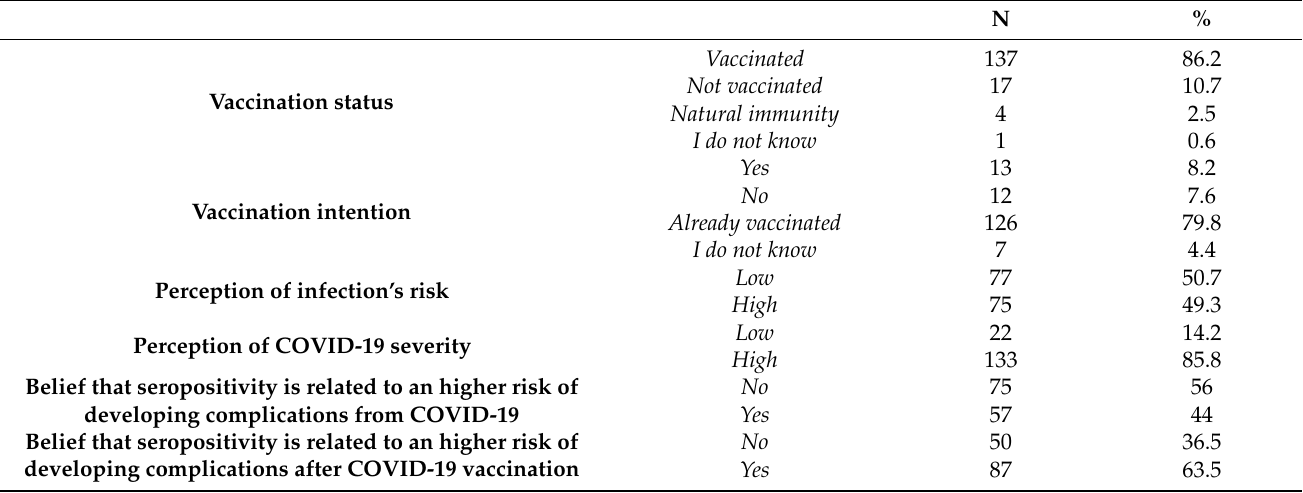
Table 2. COVID-19 Data % (n) (N =